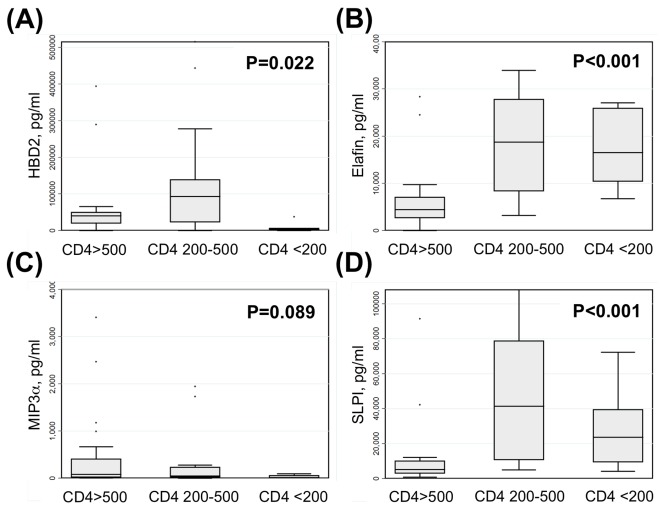
HIV disease progression exerts a selective impact on putative anti-HIV microbicides in cervicovaginal lavage fluid.(A) CVL levels of human beta defensin 2 (HBD2) were significantly lower among women with CD4<200 cells/µl. (B) CVL levels of Elafin were significantly higher among women with CD4<200 cells/µl. (C) There was a trend toward lower CVL levels of macrophage inflammatory protein-3 alpha (MIP-3α) among women with CD4<200 cells/µl. (D) CVL levels of secretory leukocyte protease inhibitor were higher among women with CD4<200 cells/µl. Bars depict median, interquartile range and 95% confidence intervals; P values derived via Kruskal-Wallis tests.